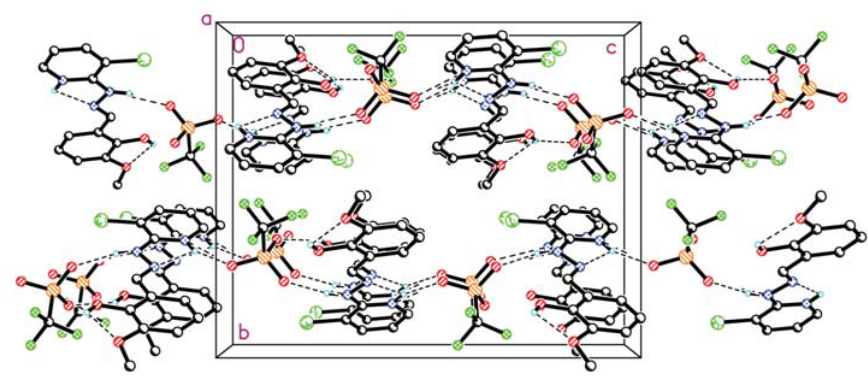
Figure 2. Packing diagram of (HL)CF